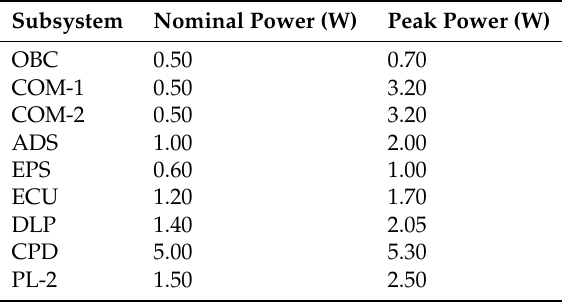
Table 1. Power consumption of Ten-Koh